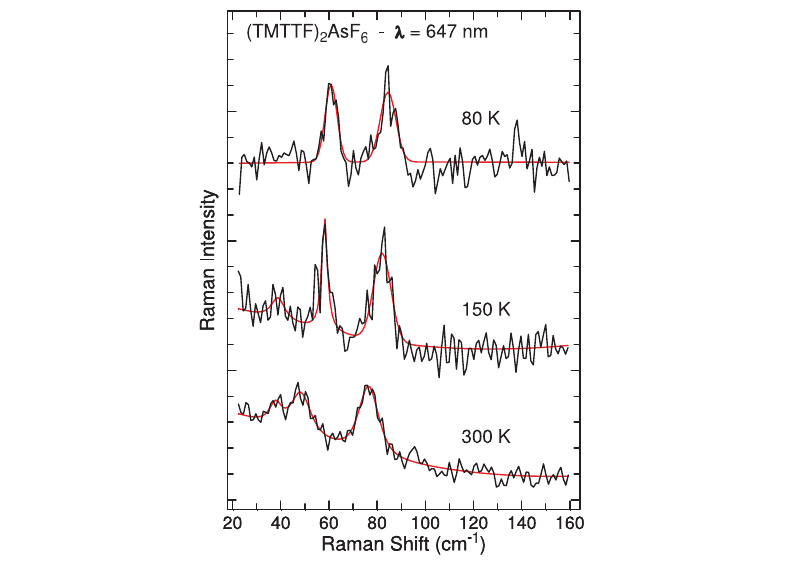
AsF as a function of 2 6